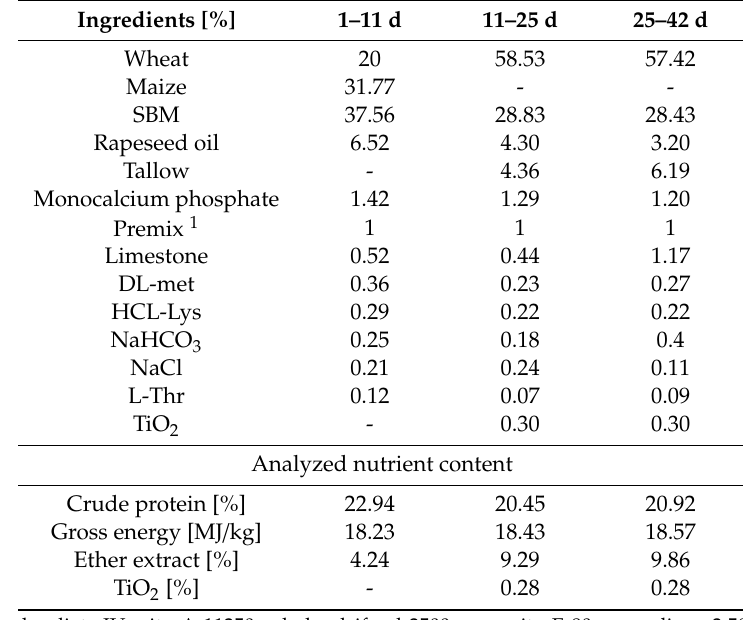
Table 1. Composition and nutrient contents of the experimental diets: starter, grower, and finisher (as feed